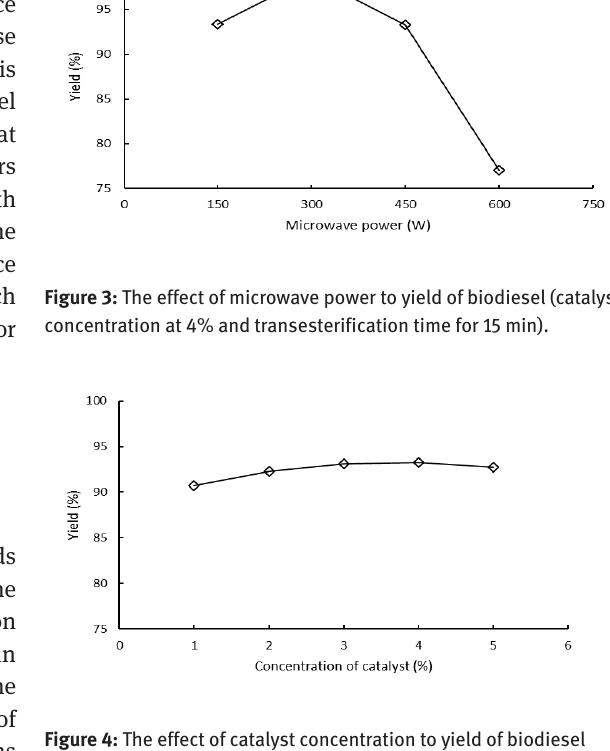
Figure 4: The effect of catalyst concentration to yield of biodiesel (microwave power at 450 W and transesterification time from 15 min).